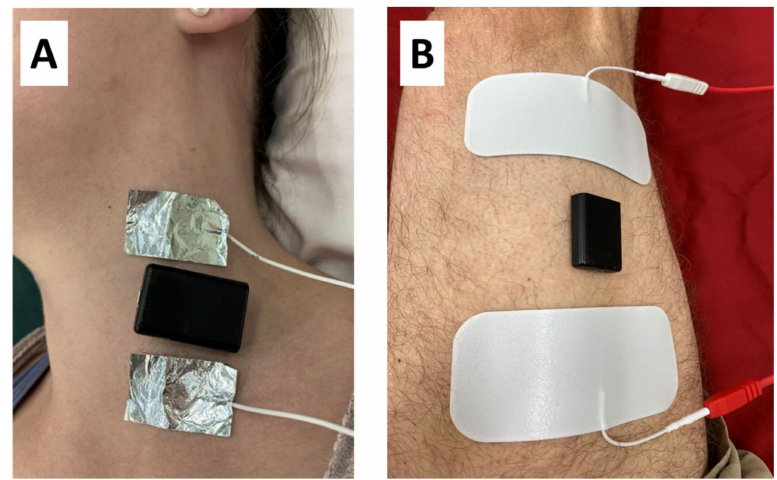
Figure 1. ( a ) The placement of the foil electrodes placed on the SCM (sternocleidomastoid) muscle, along with the tri-axial accelerometer (black). ( b ) The placement of the gel electrodes and accelerometer on the VL (vastus lateralis) muscle along with the tri-axial accelerometer